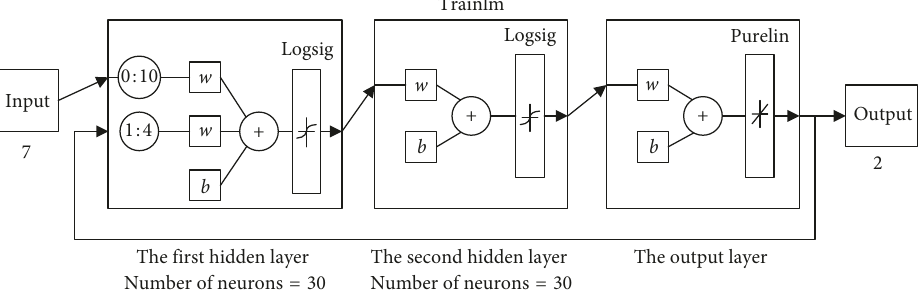
Figure 8: Architecture of the optimal NLARX model.